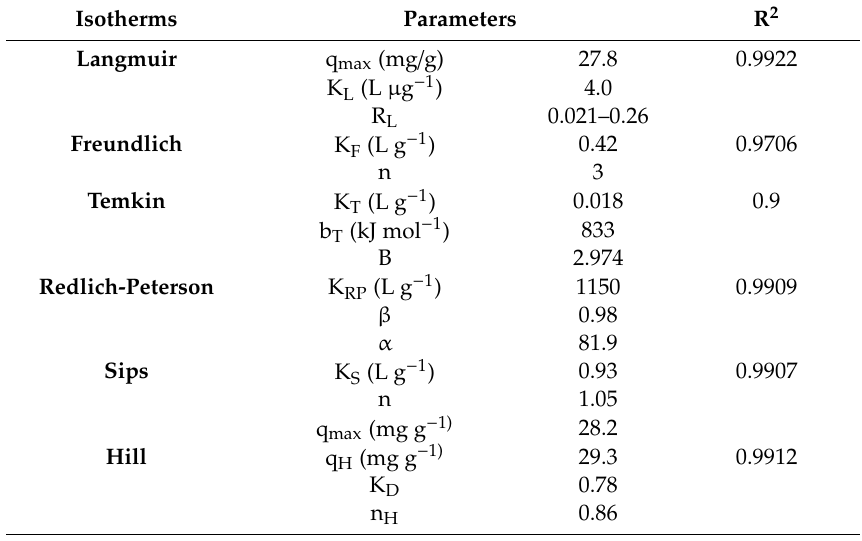
Table 3. Isotherm parameters for adsorption of arsenic on MWCNT-Fe 3 O 4 @Zeo nanocomposite.